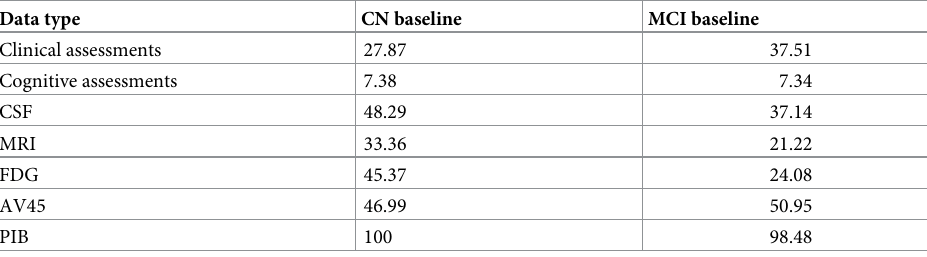
Table 3. The degree of missingness (%) in different baseline data modalities for two patient